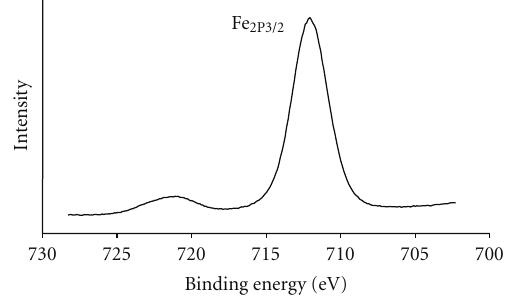
Figure 10: XPS spectrum in the range 730–700 eV for oxygen plasma-treated PMAPOSS- b -PMAHFC 1 thin